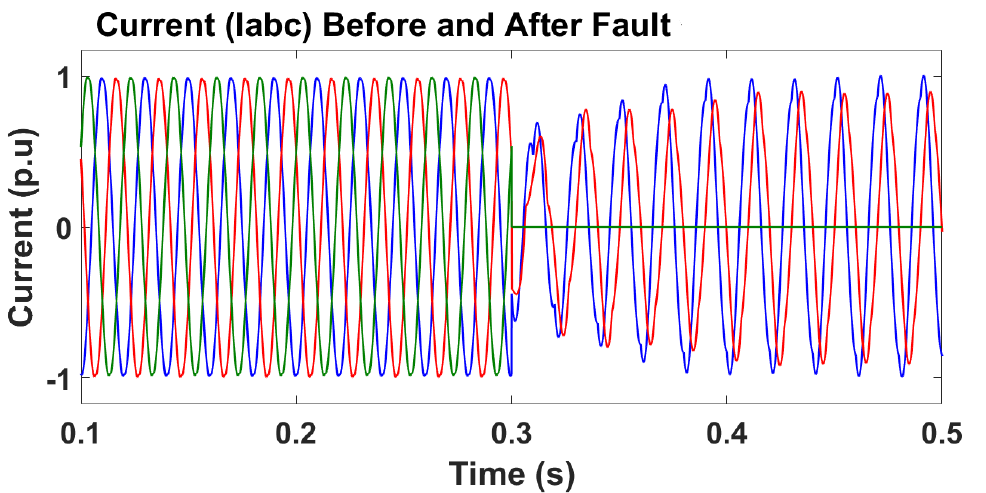
Figure 7. Current flowing from inverter to grid before and after fault with conventional control.